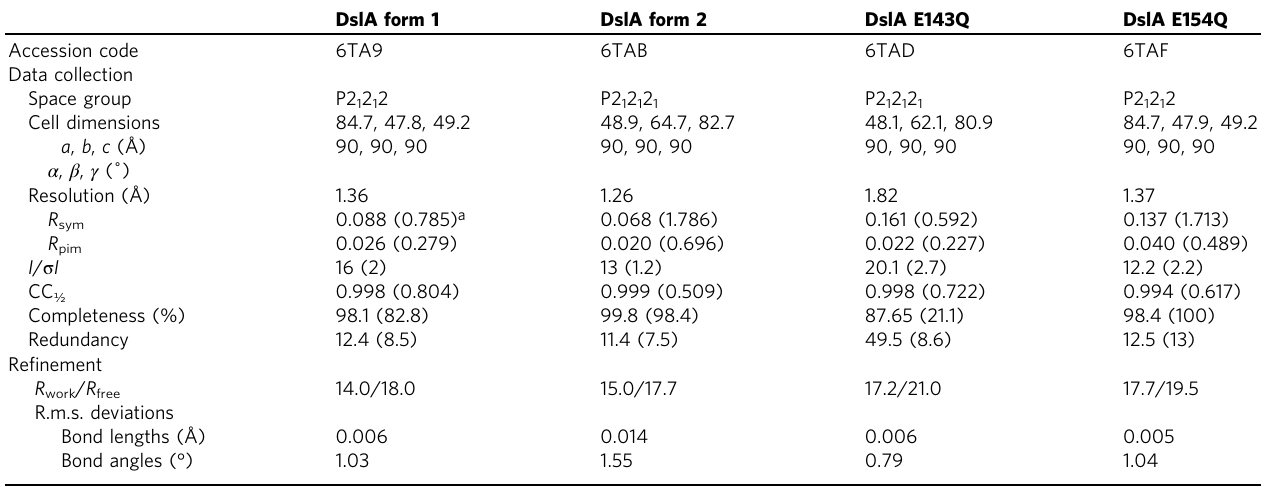
Table. 1 Data collection and re fi nement